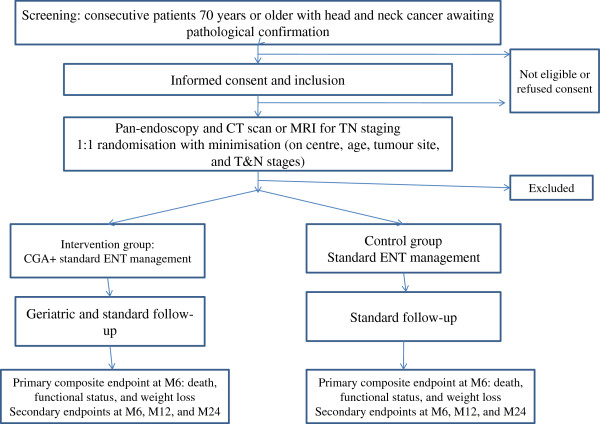
EGeSOR flow chart.